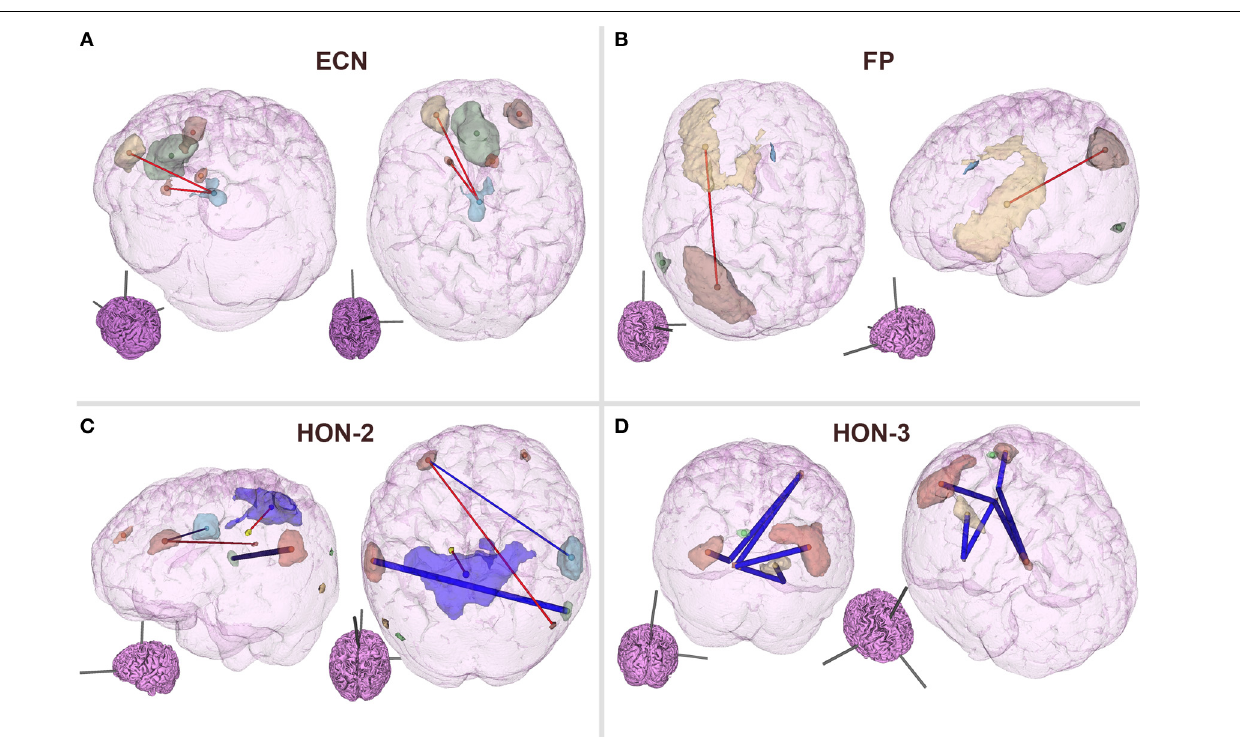
connectivity was greater and lower, respectively, in smokers relative to controls. Thick lines indicate circuits that were individually statistically different between smokers and controls, as inferred from t -tests. Inset brains indicate the orientation of the larger configuration (ECN, Executive Control Network; FP, Frontoparietal Network; HON, Higher Order